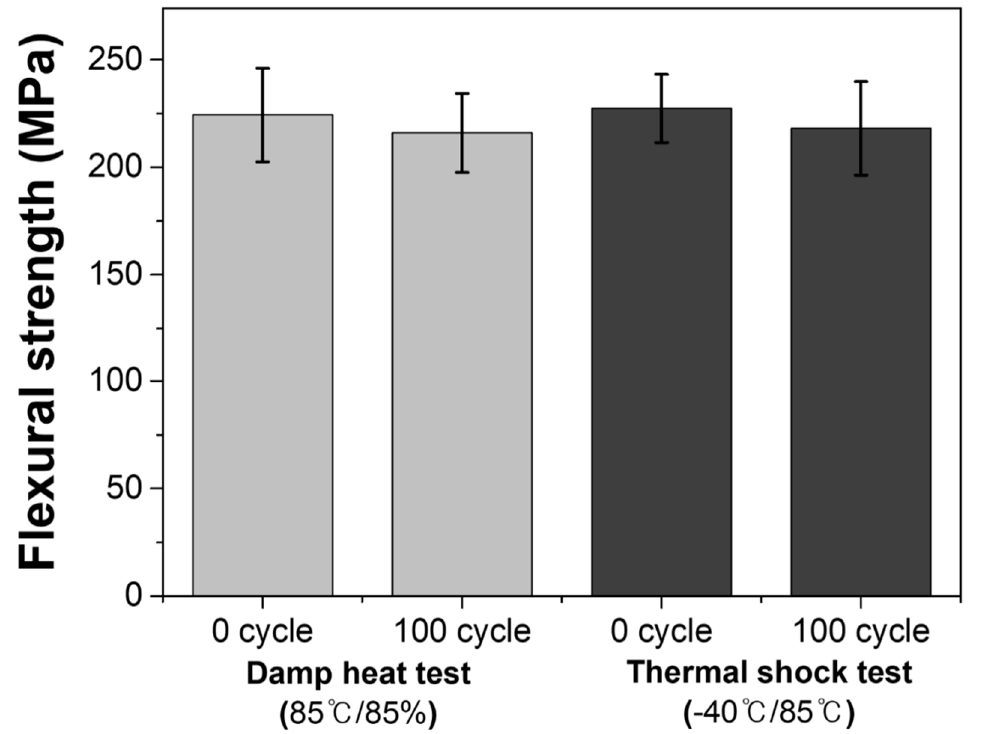
Figure 9. Variation of the flexural strength with the degradation time under damp heat test (85 °C/85%) and thermal shock test (between − 40 and 85 °C).